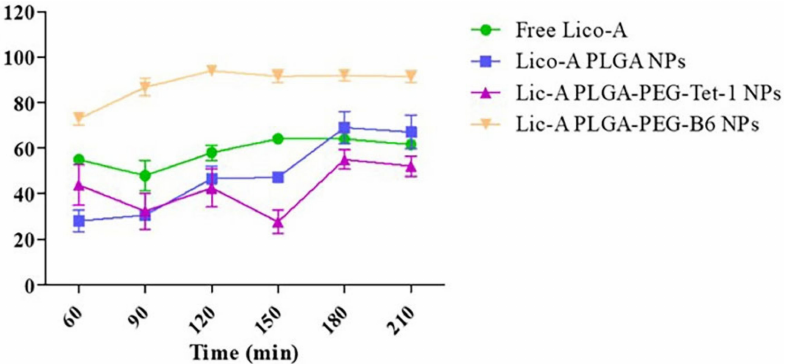
Figure 10. Inhibitory ability of different doses of licochalcone-A on ocular inflammation [96]. Copy- right 2022,